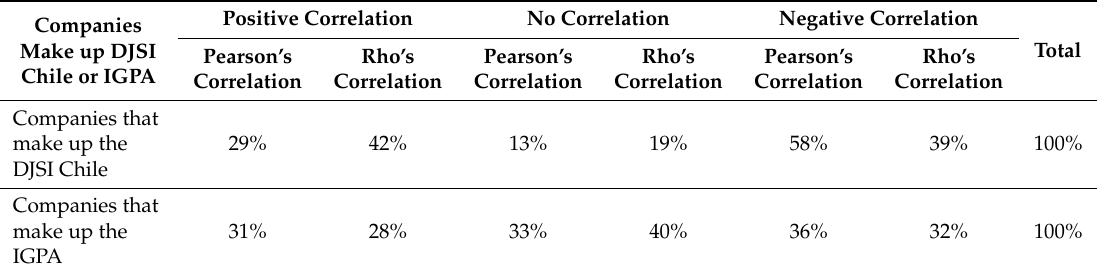
Table 6. Summary of leverage correlation with the DJSI